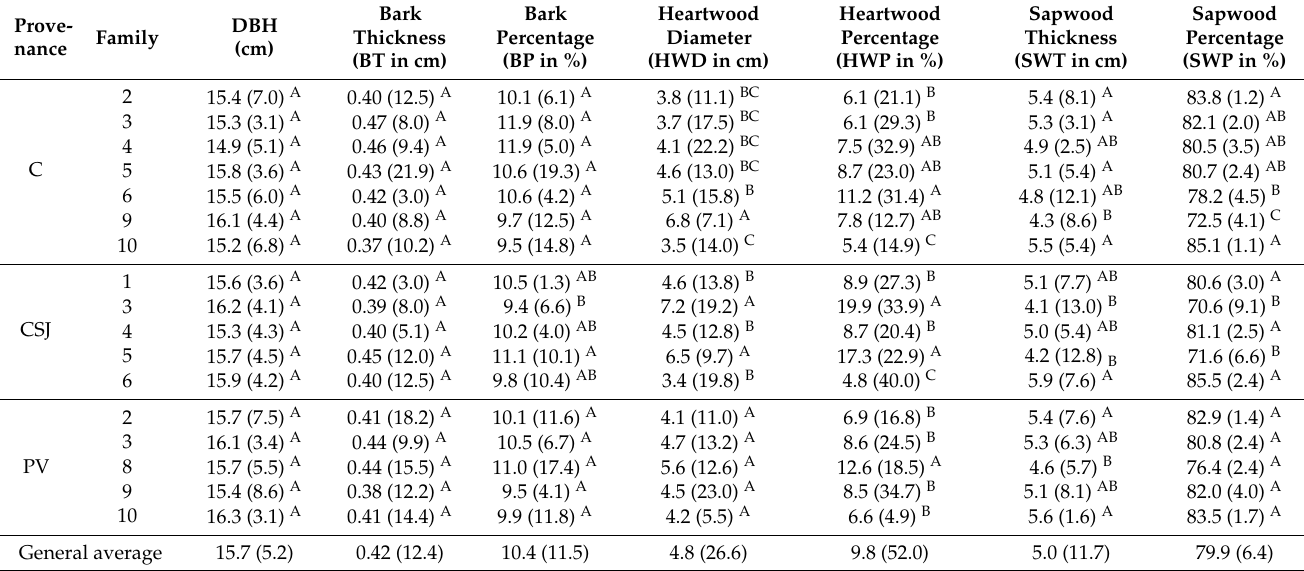
Table 1. Morphological properties variation at 8-years-old among native provenances and families of Dipteryx panamensis in Costa